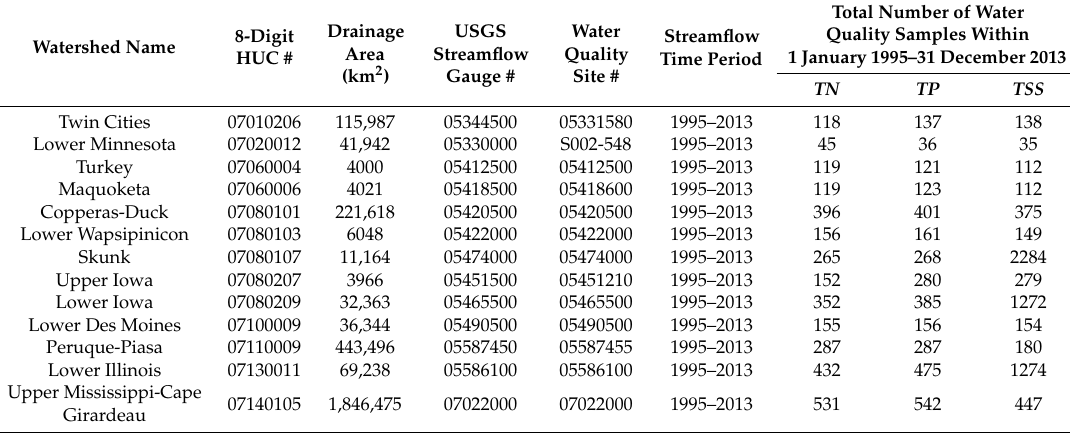
Table 1. Details of the 13 watersheds in the UMRB included in this study, along with information on their flow and water quality gauges and data